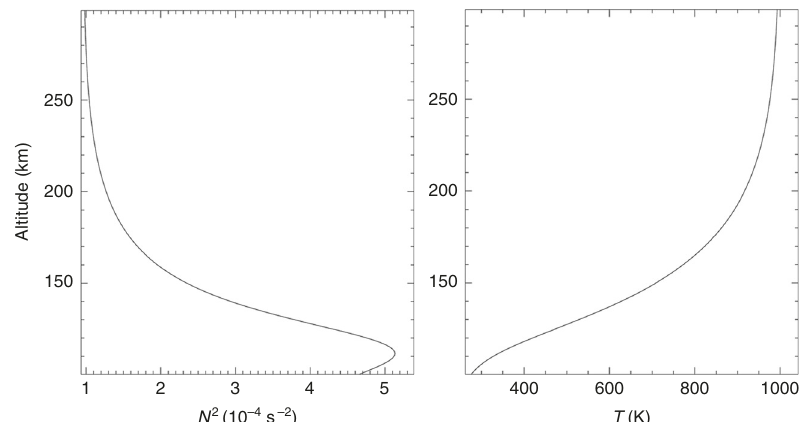
Fig. 7 Pro fi les of N 2 and T employed for the GW simulation. N 2 and T at lower altitudes asymptote to 4 × 10 − 4 s − 2 and 240 K,